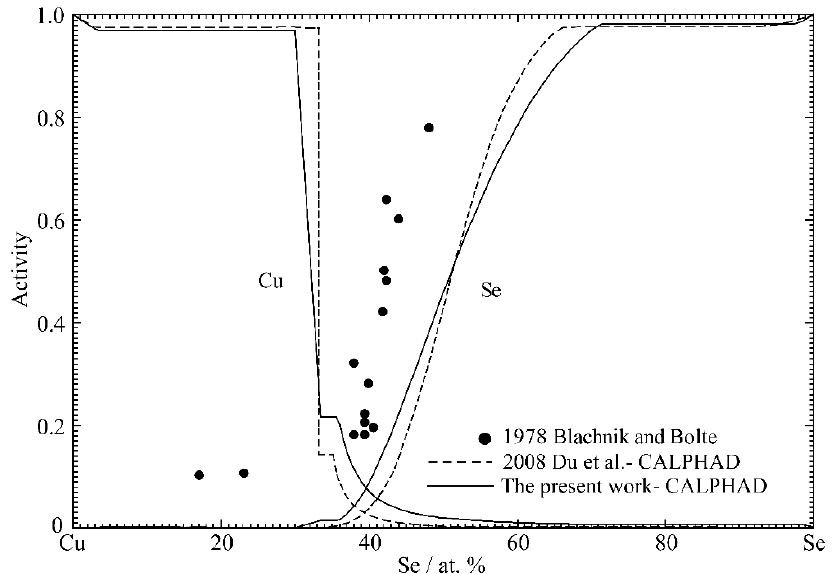
Figure 14. The calculated activities of Cu and Se at 1100 °C in the Cu-Se system compared with the experimental data from refs. [102] and previously optimized results by Du et al. [100].